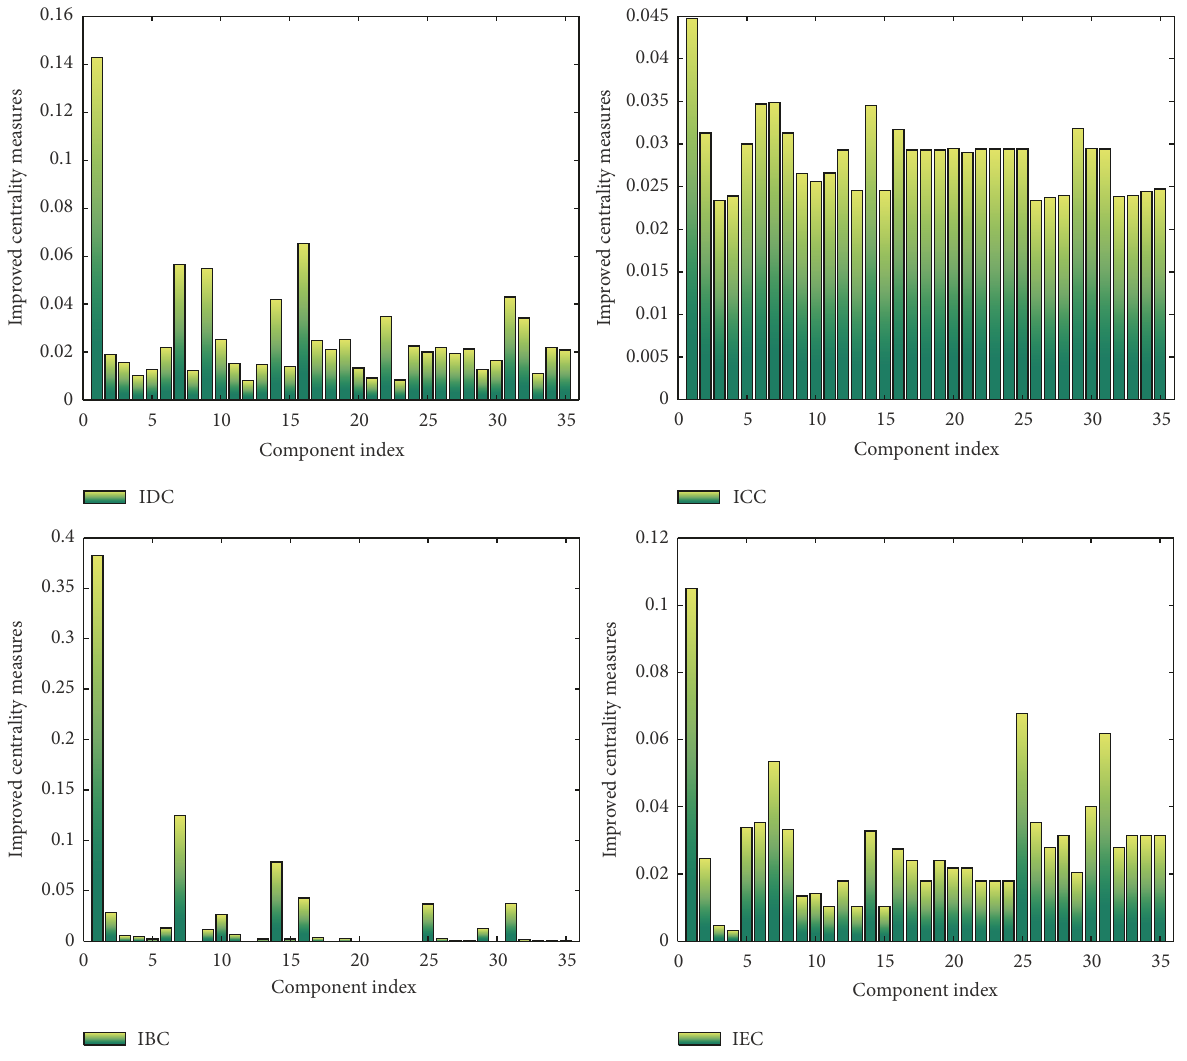
Figure 7: Improved centrality